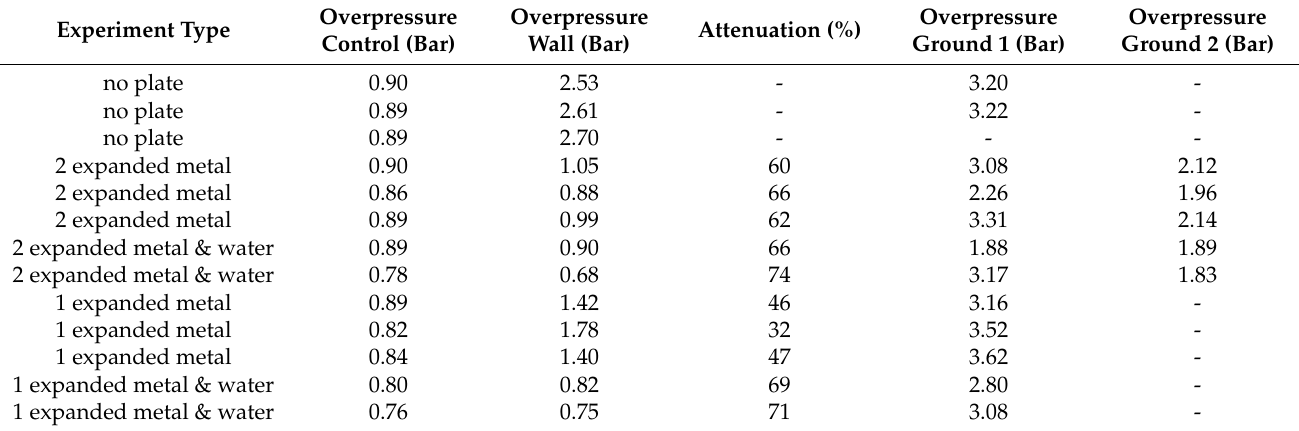
Table 2. Initial overpressure collected by three sensors (control, inserted into the wall and laid on the ground) for all experiments. The attenuation of the overpressure measured on the wall relative to the mean value obtained by the reference tests (no plate) is also given. Overpressure ground 1 and overpressure ground 2 correspond to the maximum value of the first and the second peak, respectively.